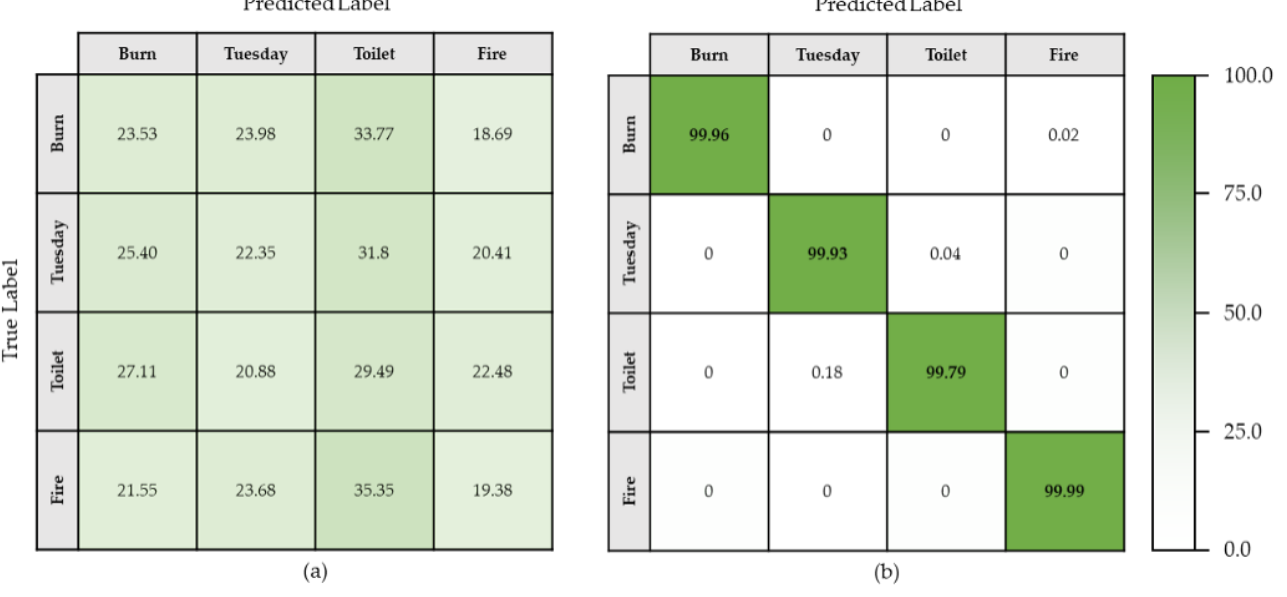
Figure 13. Confusion matrix of four words before and after data augmentation; ( a ) before data augmentation; ( b ) after data augmentation.